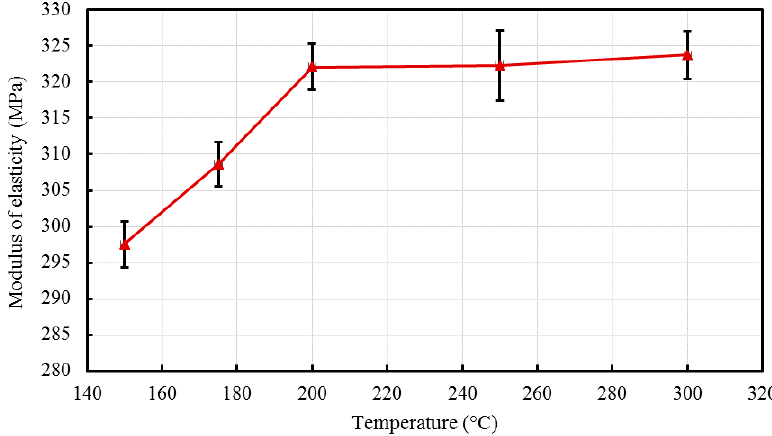
Figure 9. Effect of barrel temperature on Young’s modulus of the developed HDPE-TiO 2 nanocomposites (SE bars included).